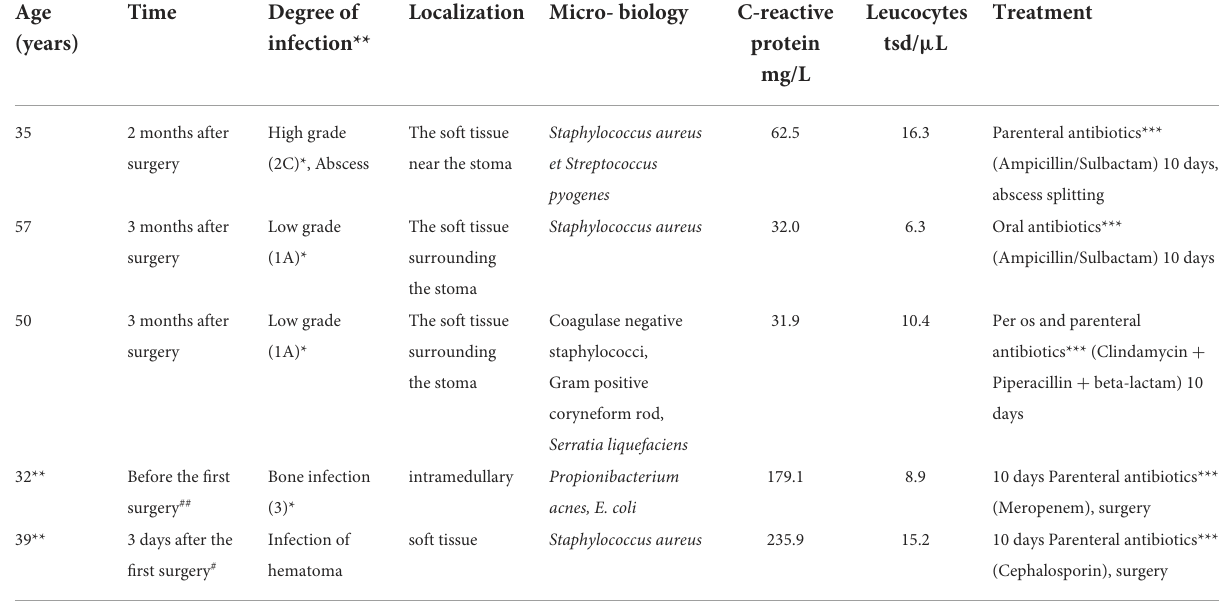
TABLE 3 Etiology and outcomes of patients with infection.